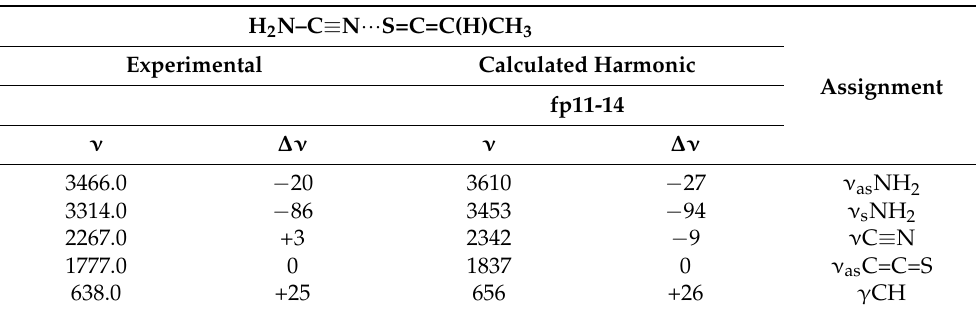
Table 6. Wavenumbers and wavenumbers shifts ( ∆ ν = ( ν comp − ν mon )) (in cm − 1 ) calculated and observed for the H 2 N–C ≡ N ··· S=C=C(H)CH 3 complex in solid argon 1